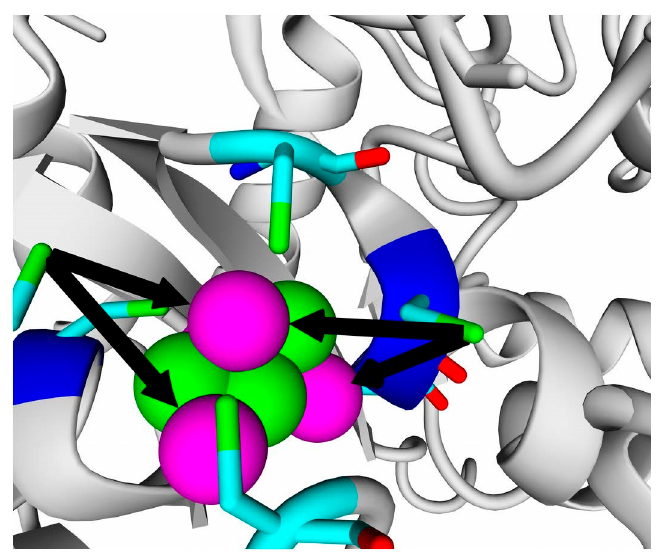
Figure 1. Proximal FeS cluster of Rba. capsulatus (model, this work). Two cysteine residues too far from the corresponding Fe atoms are marked by black arrows. Iron atoms are shown as magenta spheres, and sulfur atoms are shown as green spheres. Cysteine residues are colored by element coloring scheme: green, sulfur; cyan, carbon; blue, nitrogen; and red, oxygen.